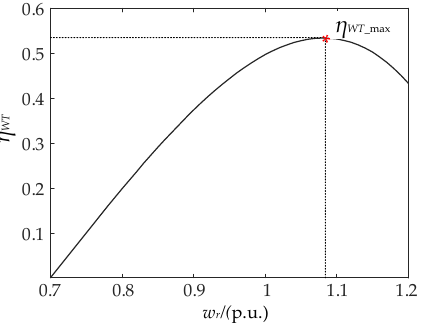
Figure 9. Curve of frequency regulation capability coefficient η WT .